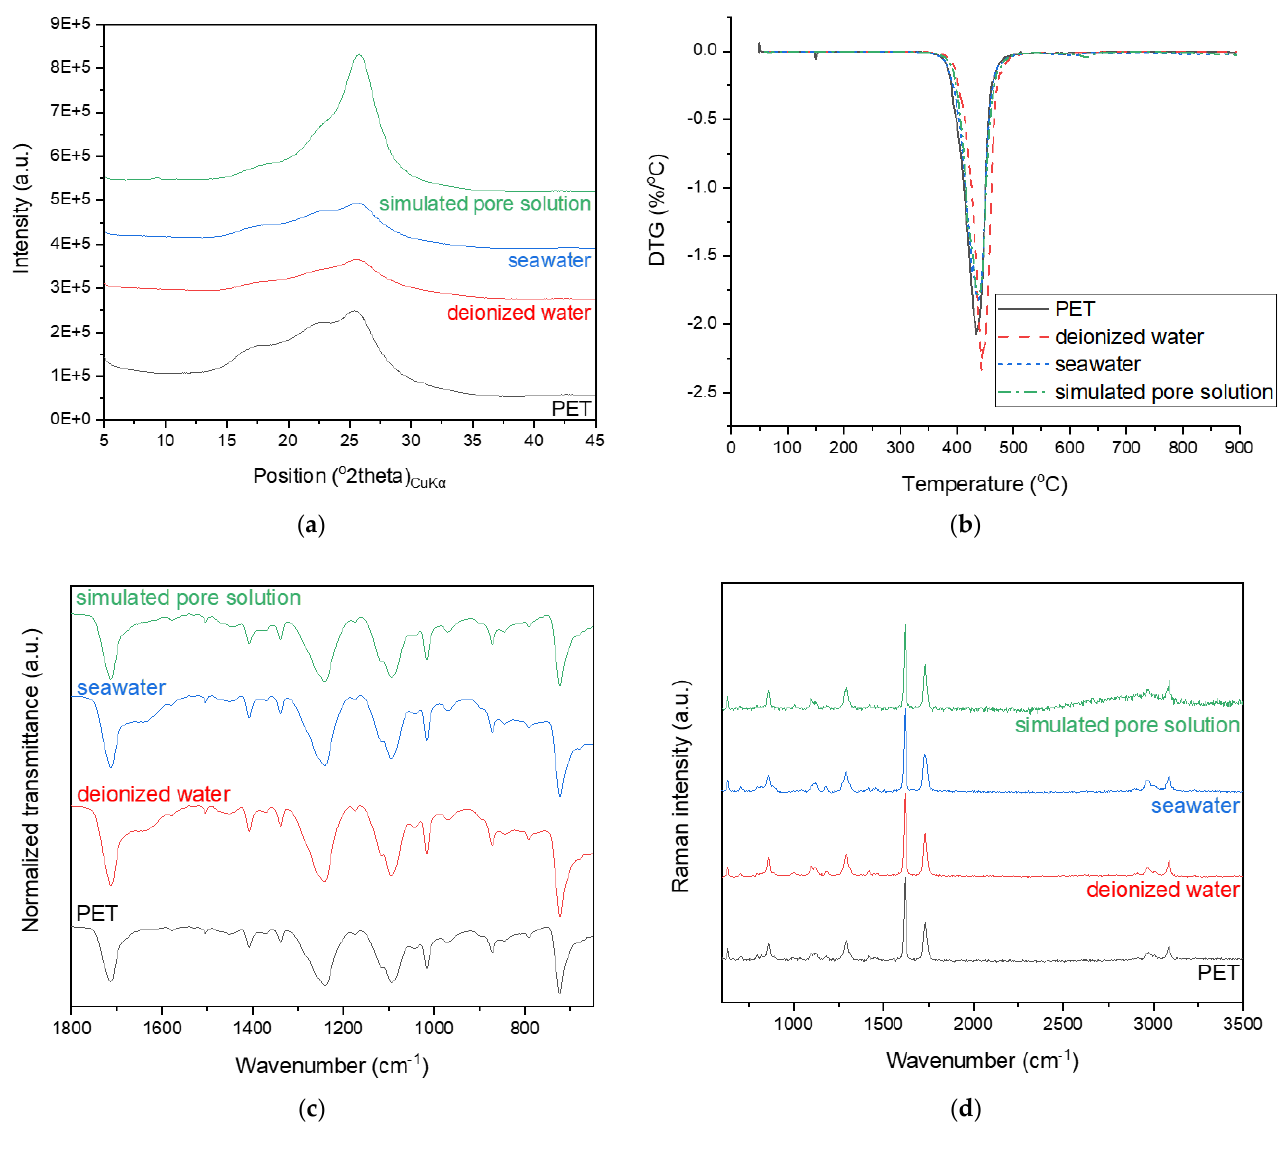
Figure 7. ( a ) XRD spectra, ( b ) DTG measurement, ( c ) FT–IR and ( d ) Raman spectra of neat PET powder and samples of PC with PET immersed in deionized water, seawater, or simulated pore solution.